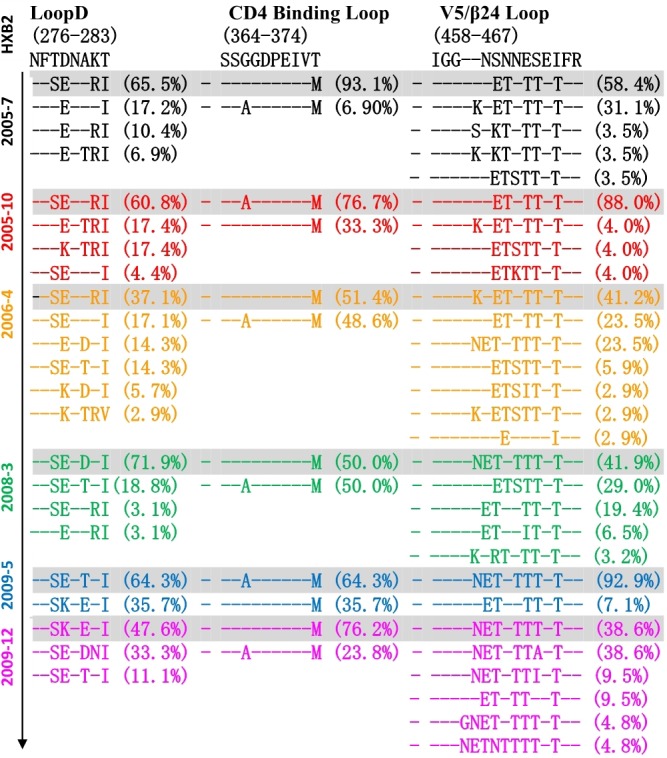
Amino acid evolutionary modes located in the contact regions of gp120 and VRC01 including loop D (276–283), CD4 binding loop (364–374) and V5/β24 loop (458–467) in six time points (HXB2 numbering is indicated). Different amino acids sequences in three contact regions were sorted and denoted percentage in 155 Env sequences of six time points, and – (dashed) represents same residues with HXB2. The sequences were color coded as follows: black, June 2005; red, October 2005; yellow, 2006; green, 2008; blue, May 2009; purple, December 2009. The dominant variants presented more mutations in loop D at later time point, and the highest diversification of loop D was found at 2006-04 time point. CD4 binding loop exhibited lower diversification spanning all six time points, and more diversification in V5 was found in the dominant variants at later time point.